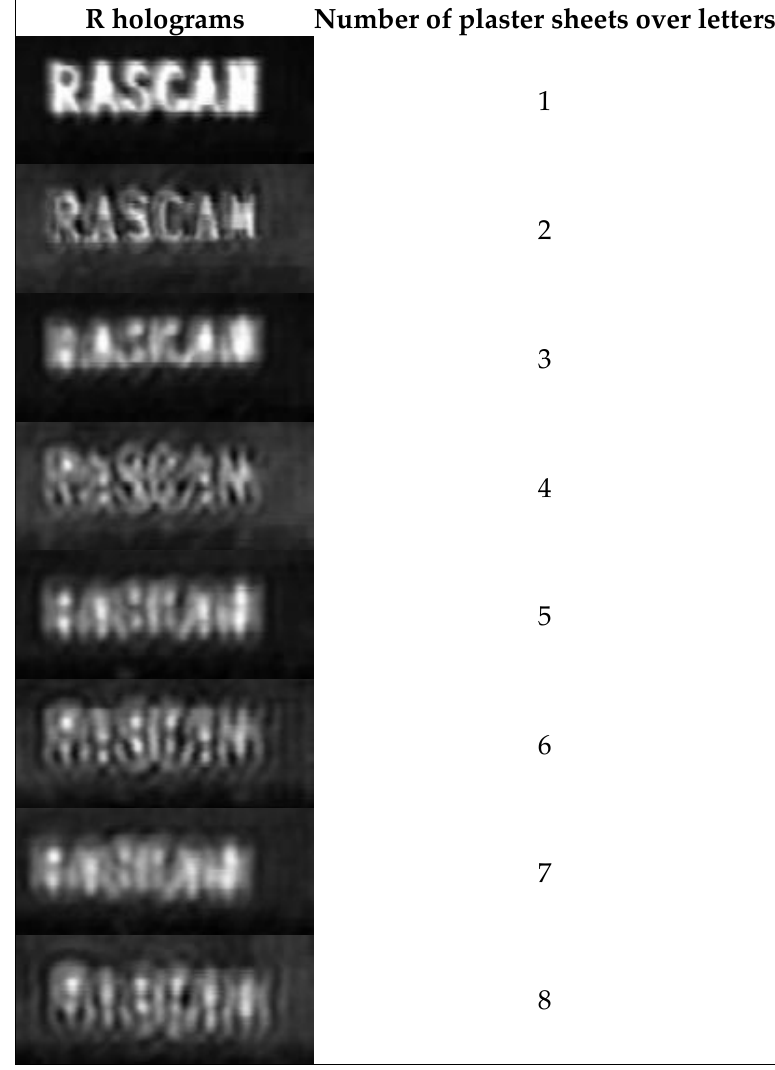
Figure 6. RASCAN holograms recorded through varying stacks of plaster